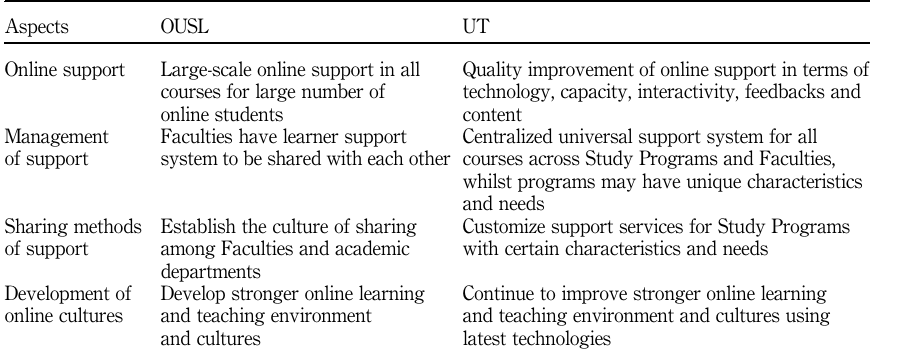
Table 5. Challenges